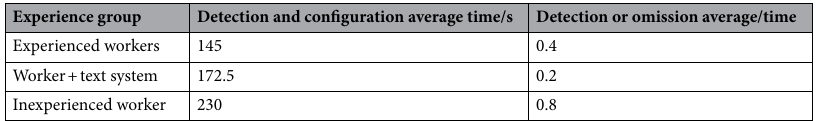
Table 4. Performance test of manual method and this